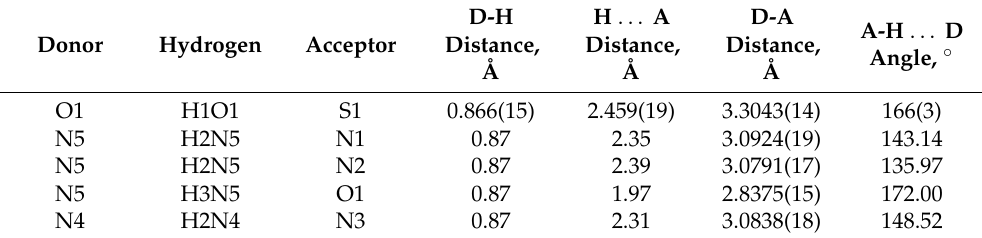
Figure 5. The first type of interaction was the N—H···N and corresponded to the hydrogen bond between ammonium cation and the thiocyanate nitrogen. The second type of inter- action was the N—H···O and corresponded to the bond between ammonium cation and a water molecule. The third type of interaction was the O—H···S and corresponded to the bond between a water molecule and thiocyanate sulfur. The second and third hydrogen bonding types were only observed with the equatorial thiocyanate ligands. All these bonds, detected by SCXRD, were in agreement with the observed vibrational bands in the FTIR spectrum .